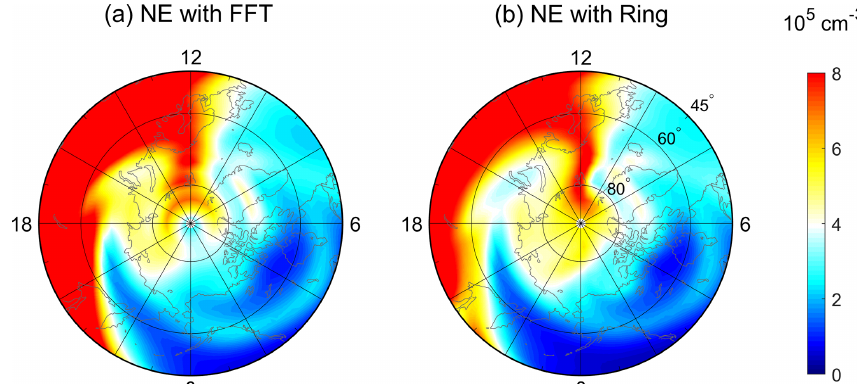
Figure 6. The simulated polar maps of electron densities using (a) an FFT filter and (b) ring average at pressure surface 2 (near the F 2 -region peak, ∼ 300km) at 10:50UT on 17 March 2013 as a function of geographic latitude and local time. Both simulations have a horizontal resolution of 2 . 5 ◦ × 2 . 5 ◦ . The outer boundary is at 45 ◦ N geographic